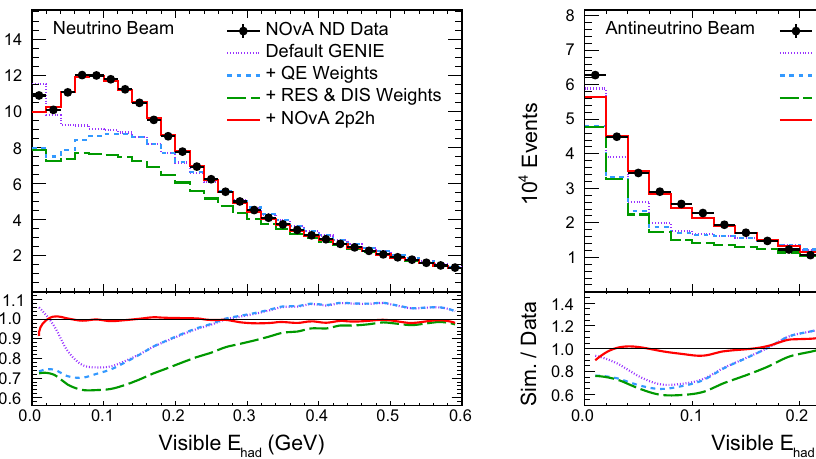
Fig. 6 Visible hadronic energy distributions showing each step of our simulation adjustment process. The purple dotted histogram indicates the default GENIE simulation without any 2p2h. The blue dashed line shows the effect of adding modifications to QE (adjusting M A and the nuclear model). The RES and soft non-resonant single pion production